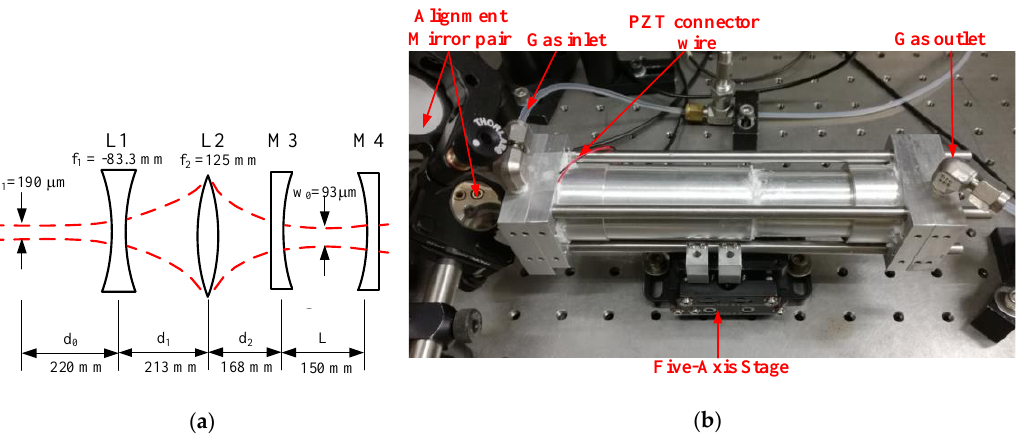
Figure 2. ( a ) Mode matching design of the cavity. ( b ) Photograph of the sealed F-P cavity with gas inlet and outlet connectors .